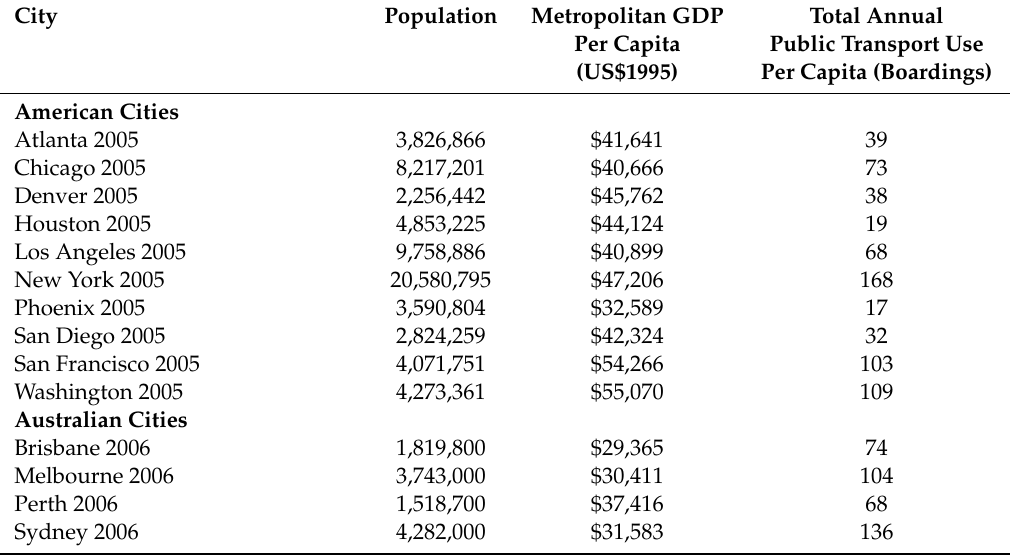
Table 1. List of cities used for the international comparisons with their population, GDP per capita and annual public transport use per